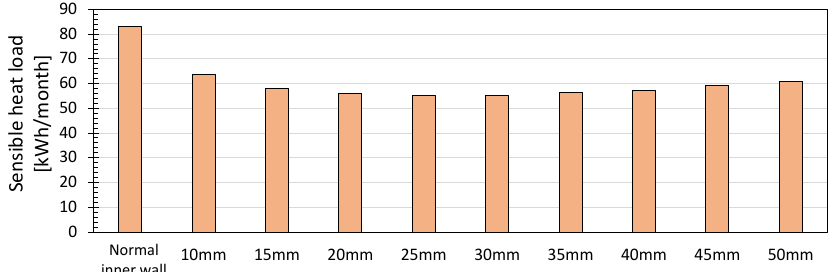
Figure 13. Effect of heat-storage wall thickness on heat load (living room, February).